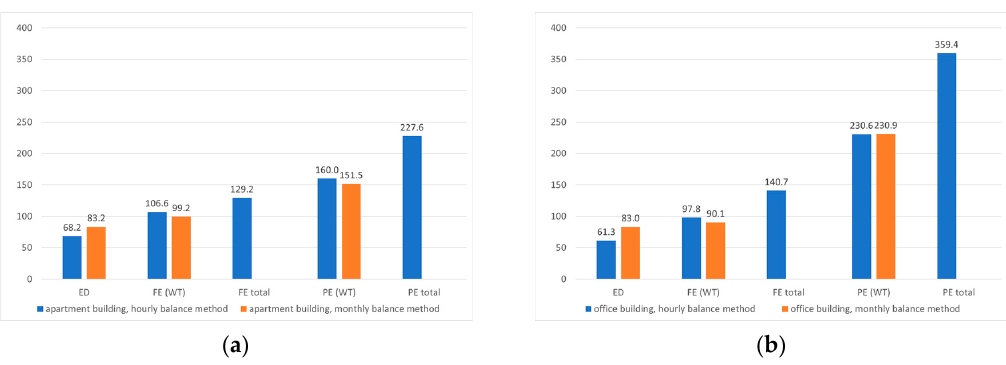
Figure 7. Comparison of energy demand using hourly and monthly balance methods for: ( a ) Energy demand for apartment